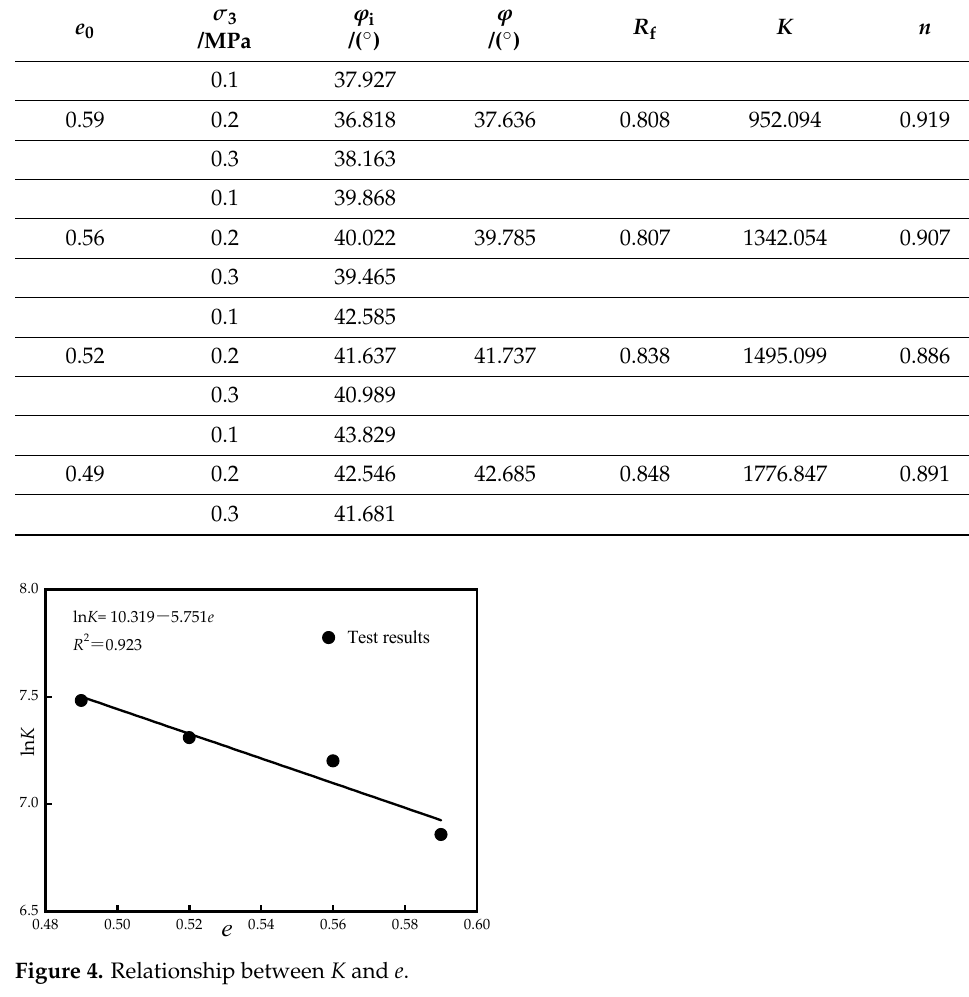
Table 4. Parameters of the ISO dry sands for each case.